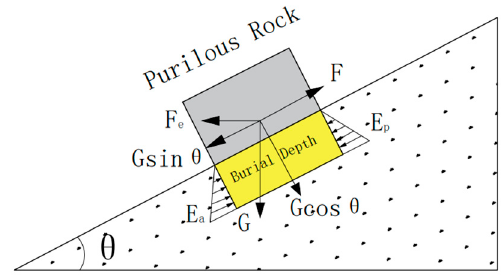
Figure 8. Force diagram of perilous rock.